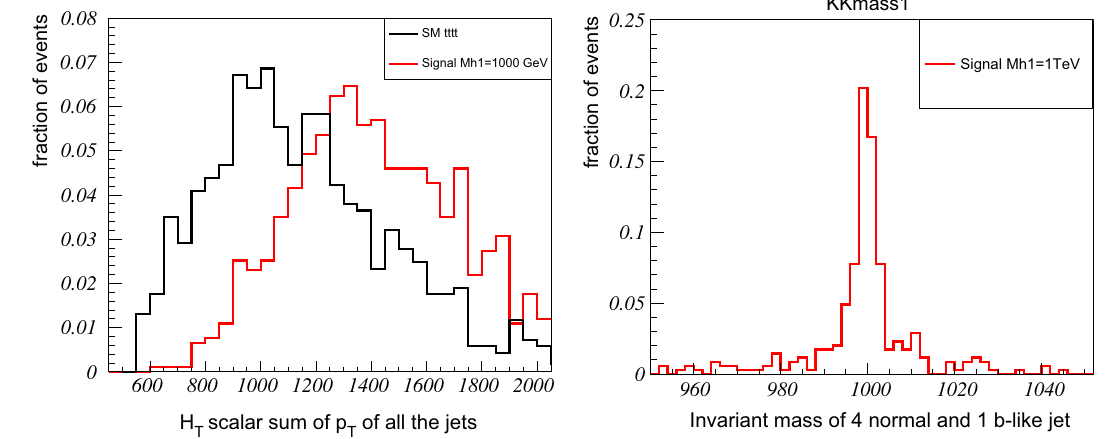
Fig. 2 Scalar sum of p T of jets to the left and the H 1 mass reconstruction to the